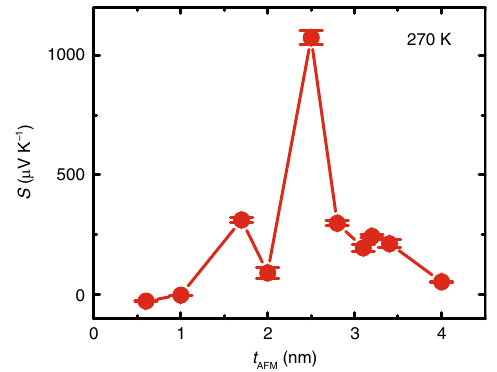
Fig. 3 Thickness-dependent Seebeck effect at the temperature of 270K. The Seebeck coef fi cients at 270K for samples with different thickness of 0.6, 1.0, 1.7, 2.0, 2.5, 2.8, 3.1, 3.2, 3.4, and 4.0 nm are extracted from the